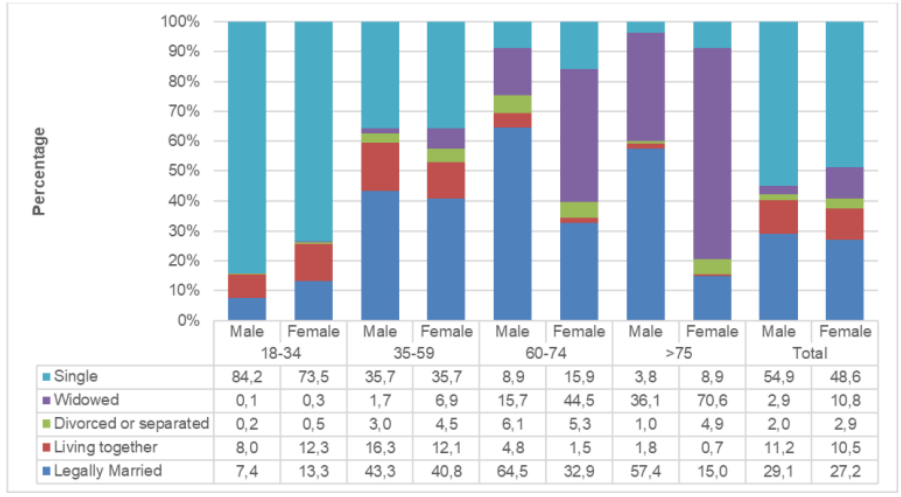
Figure 1: Marital status of people ageas 18 and older; Source: StatsSA